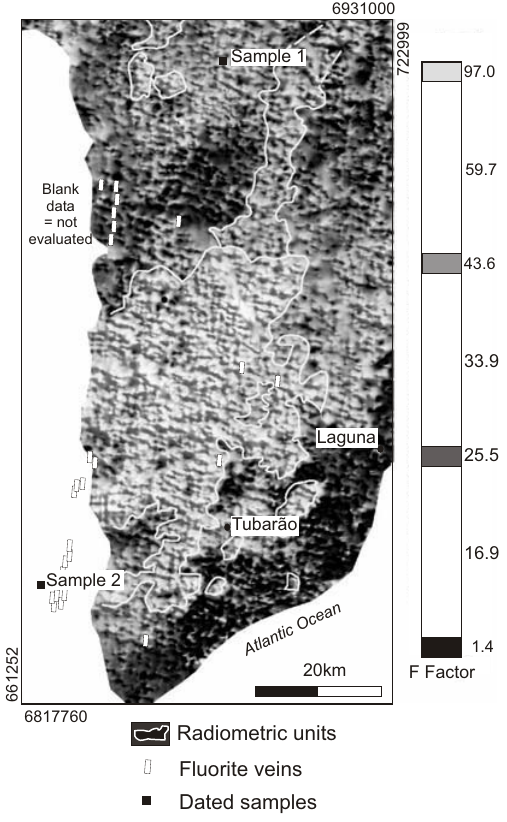
Fig. 6 – Radiometric image factor F (F = K ∗ U/Th) counting with location of the fluorite veins. Modified after Hoff (unpublished data).